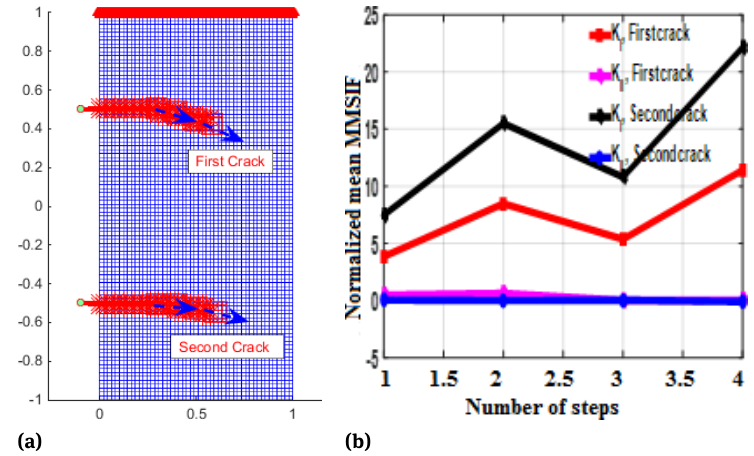
Figure 6: (a) Crack propagation path for double edge crack plate under combined loading and (b) Normalized MMSIF